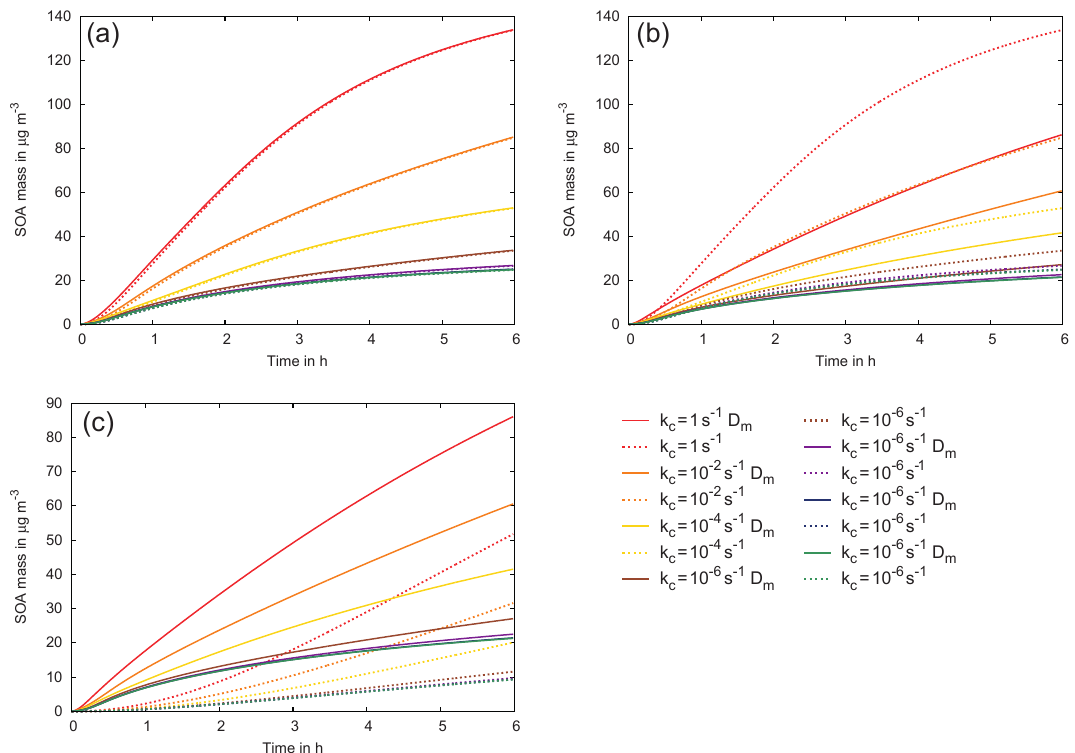
Figure 7. Simulated SOA mass considering an effective particle-phase bulk diffusion coefficient under additional variation of the pseudo- first-order rate constant of particle reactions k c (case 8 of Table 1). (a) Organic material is considered with a diffusion coefficient of D org = 10 − 12 m 2 s − 1 in the weighted particle-phase bulk diffusion coefficient D m (solid lines), and for comparison the results for D b = 10 − 12 m 2 s − 1 are shown (dashed lines); (b) organic material is considered with a diffusion coefficient of D org = 10 − 14 m 2 s − 1 in the weighted particle-phase bulk diffusion coefficient D m (solid lines) and for comparison the results for D b = 10 − 12 m 2 s − 1 are shown (dashed lines); (c) organic material is considered with a diffusion coefficient of D org = 10 − 14 m 2 s − 1 in the weighted particle-phase bulk diffusion coefficient D m (solid lines), and for comparison the results for D b = 10 − 14 m 2 s − 1 are shown (dashed